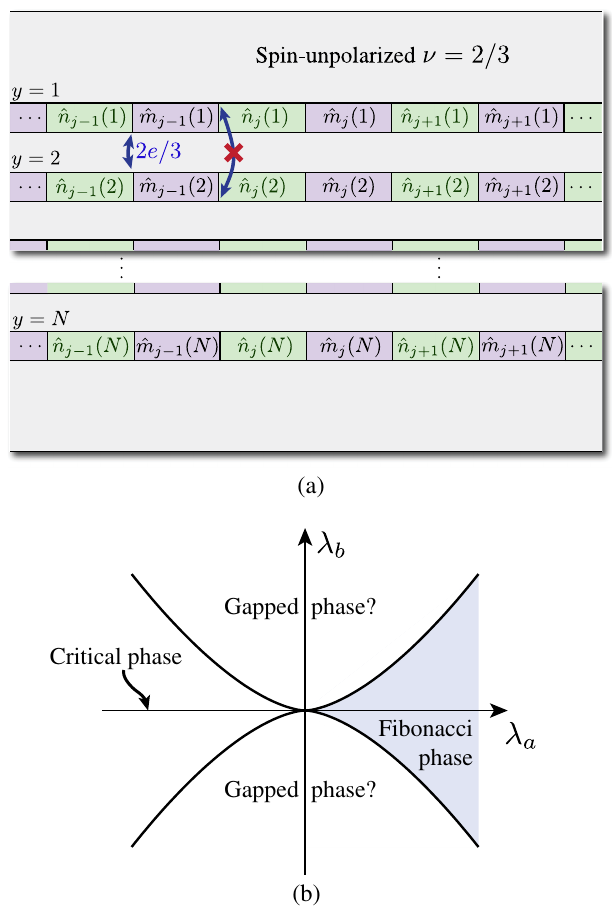
FIG. 6. (a) Multichain generalization of Fig. 5 in which a sequence of trenches labeled by y ¼ 1 ; :::::; N is embedded in a spin-unpolarized ν ¼ 2 = 3 quantum Hall system. Once again, the edge modes opposite each trench are alternately gapped by electron backscattering and Cooper pairing, with ˆ m i ð y Þ and ˆ n y Þ characterizing the pinned charge-sector fields in a given i ð domain [see Eqs. (44) and (45)]. We assume that the Z 3 generalized Majorana operators bound to each domain wall hybridize strongly within a trench and weakly between neighbor- ing trenches. Underlying this hybridization is tunneling of 2 e= 3 charges, which can only take place through the fractional quantum Hall fluid; examples of allowed and disallowed proc- esses are illustrated above. (b) Phase diagram for this system of weakly coupled chains starting from the limit where each chain is tuned to a critical point described by Z 3 parafermion conformal field theory. The couplings λ a=b represent interchain perturbations defined in Eq.